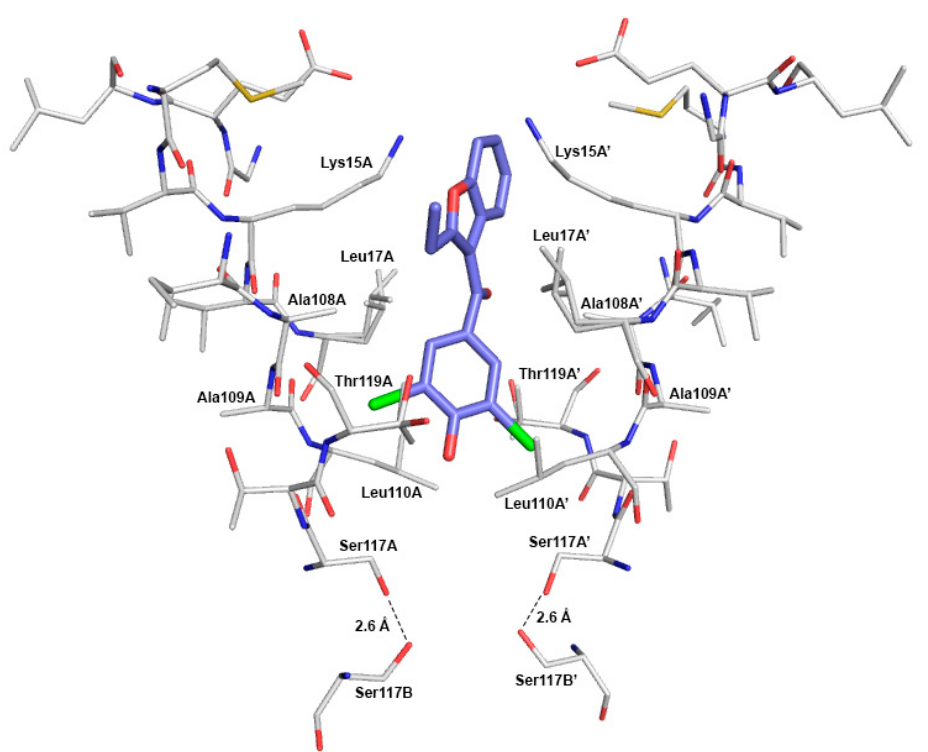
Figure 7. Close view of the interactions of benzbromarone (BBM) with the TTR AA’ binding site (carbon atoms in grey, nitrogen atoms in dark blue, oxygen in red, sulfur in dark yellow and bromine atoms of BBM in green).